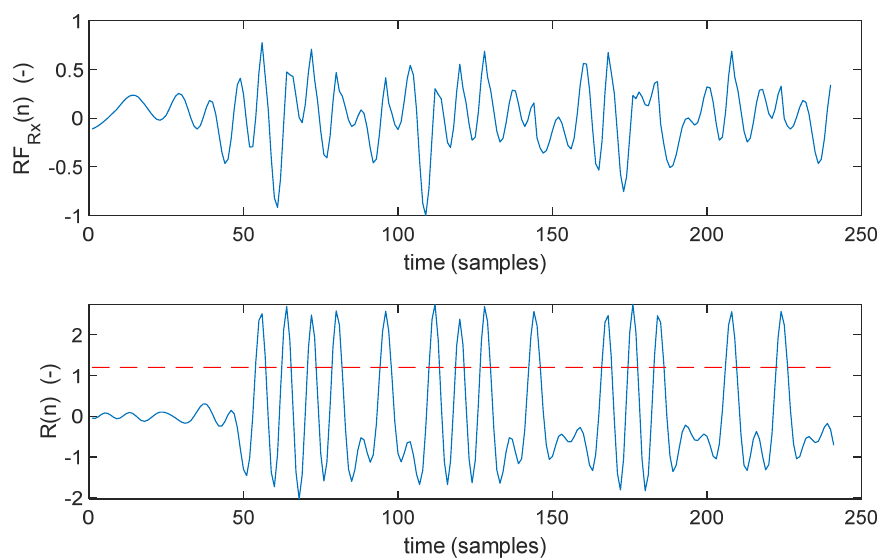
Figure 4. The received signal (top) is correlated to the chirp to obtain the compressed signal (bottom). The bitstream is recovered by detecting the peaks through a threshold (red dashed line). In this example, the 24-bit packet “111101011101001110010100” is detected.